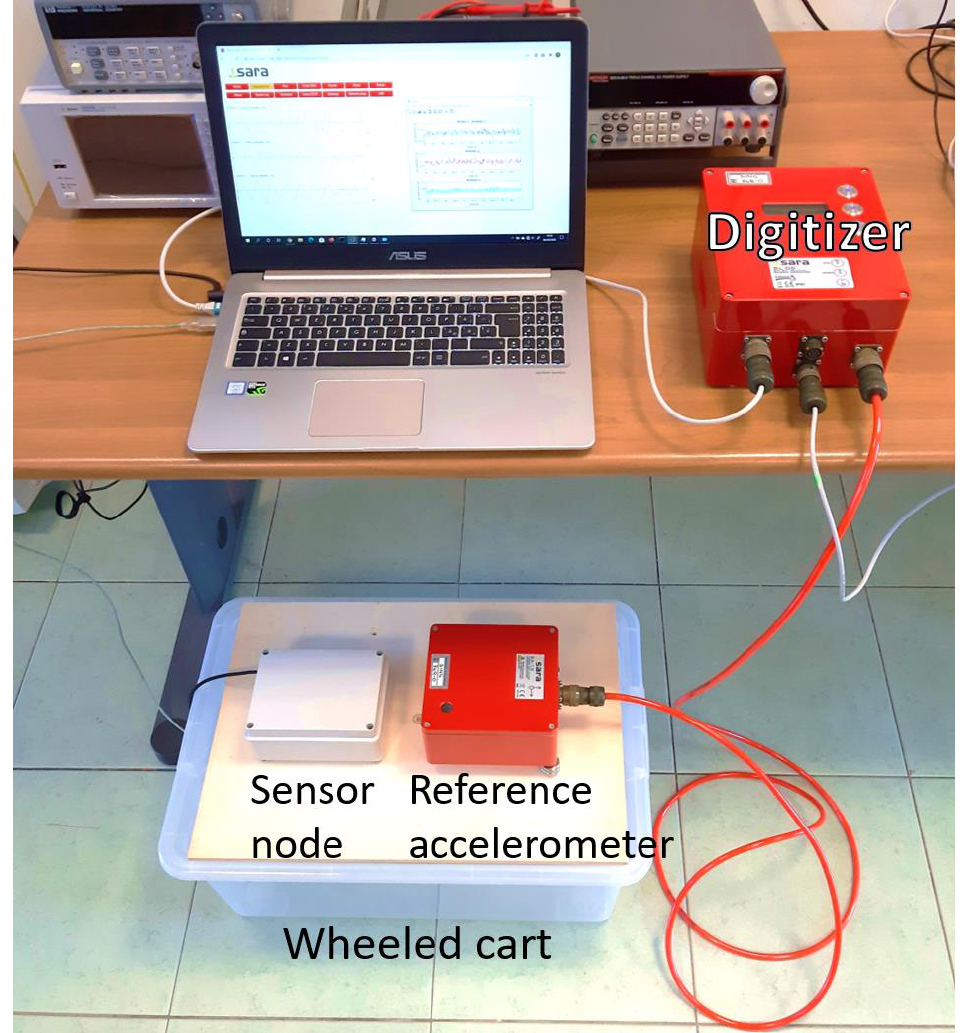
Figure 3. Laboratory test set up. The sensor node is placed on a wheeled cart (left side of the cart), alongside the reference accelerometer (right).